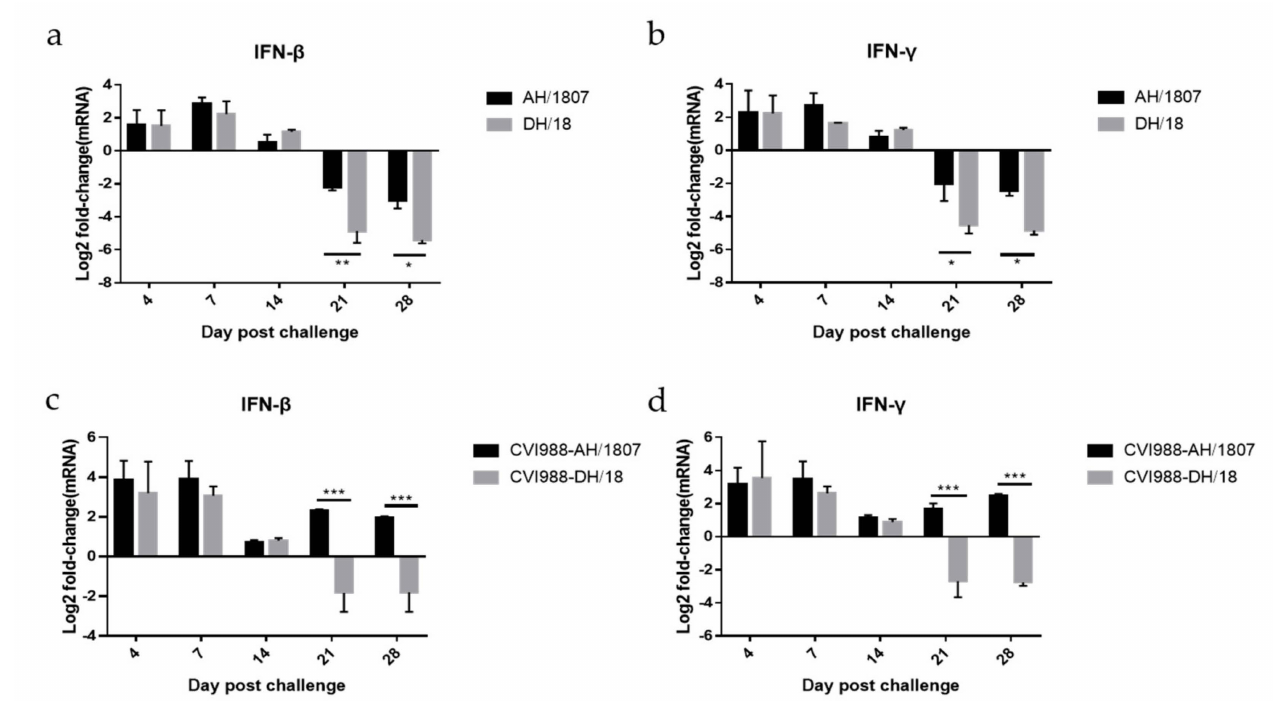
Figure 7. The mRNA expression of IFN- β and IFN- γ in the spleen. Three chickens were randomly selected at each time point (4-, 7-, 14-, 21-, and 28-days post challenge), and the relative expression of interferons (IFNs) was detected using quantitative real-time polymerase chain reaction. Bars above the horizontal line were upregulated and those below were downregulated. Comparing the expression levels of ( a ) IFN- β and ( b ) IFN- γ between AH/1807 and DH/18 groups. Comparing the expression levels of ( c ) IFN- β and ( d ) IFN- γ between CVI988-AH/1807 and CVI988-DH/18 groups. Two-way ANOVA was performed for significance analysis. The data are shown as means with standard deviations (SDs). * p < 0.05, ** p < 0.01, *** p < 0.001.